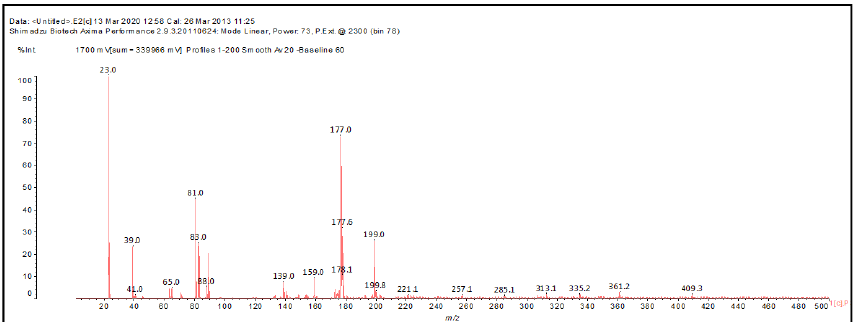
Figure 4. MALDI ToF spectrum of humins obtained at 180 °C from fructose, 20 – 500 Da range.